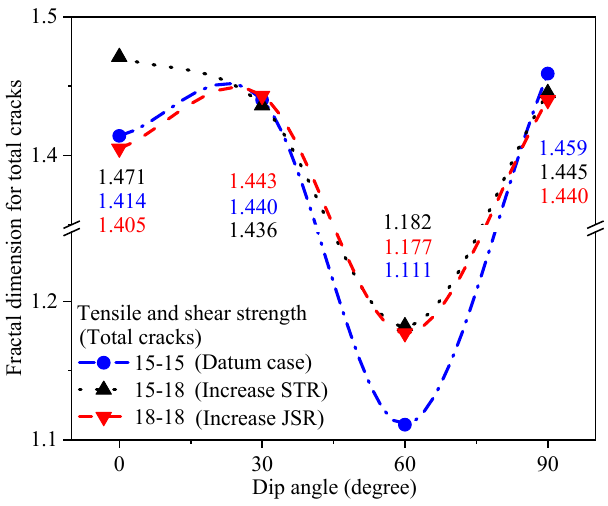
Figure 17. Variation of crack fractal dimension with dip angle at three bedding strength parameters. Table 3. Average of fractal dimension for different micro-cracking morphology in three cases.